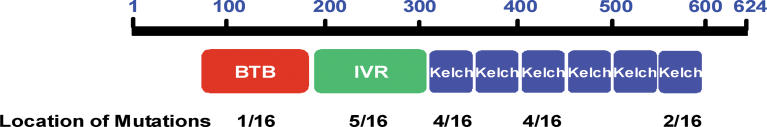
Schematic of the Conserved Domain Structure of Human KEAP1 ProteinThe protein consists of an N-terminal region (amino acids 1–60), a BTB domain (amino acids 61–179), a central IVR (amino acids 180–314), a double-glycine-rich region comprising six Kelch motifs (amino acids 315–359, 361–410, 412–457, 459–504, 506–551, and 553–598), and a C-terminal domain (amino acids 599–624). The frequency of mutations detected within each domain is indicated below. Amino acid positions of the mutations are listed in Table 1.